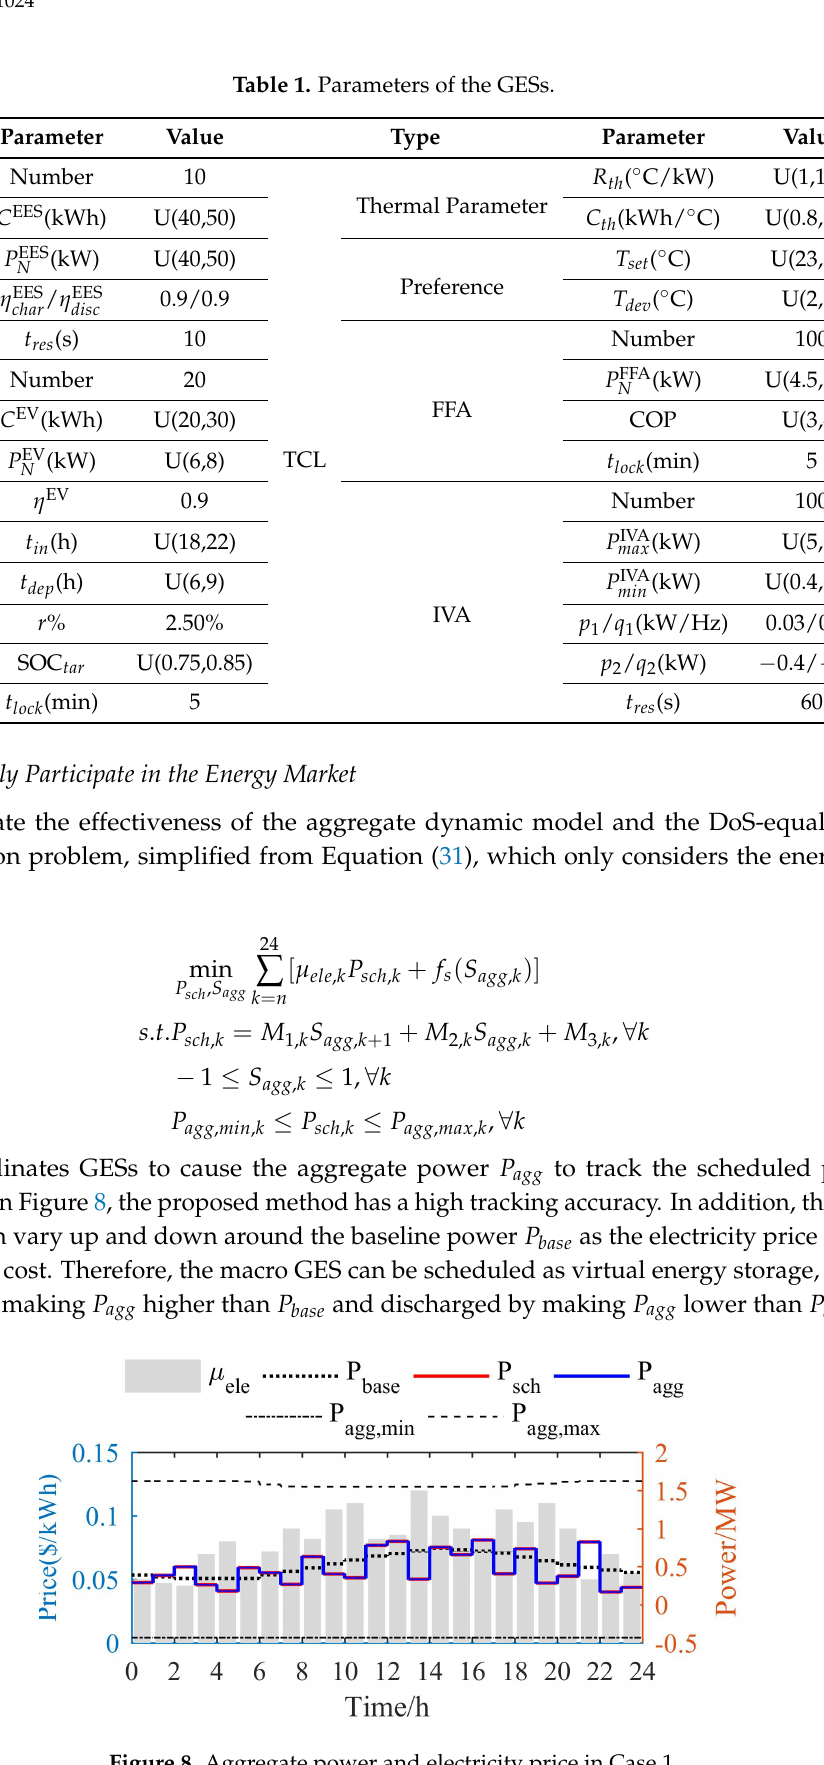
Figure 8. Aggregate power and electricity price in Case